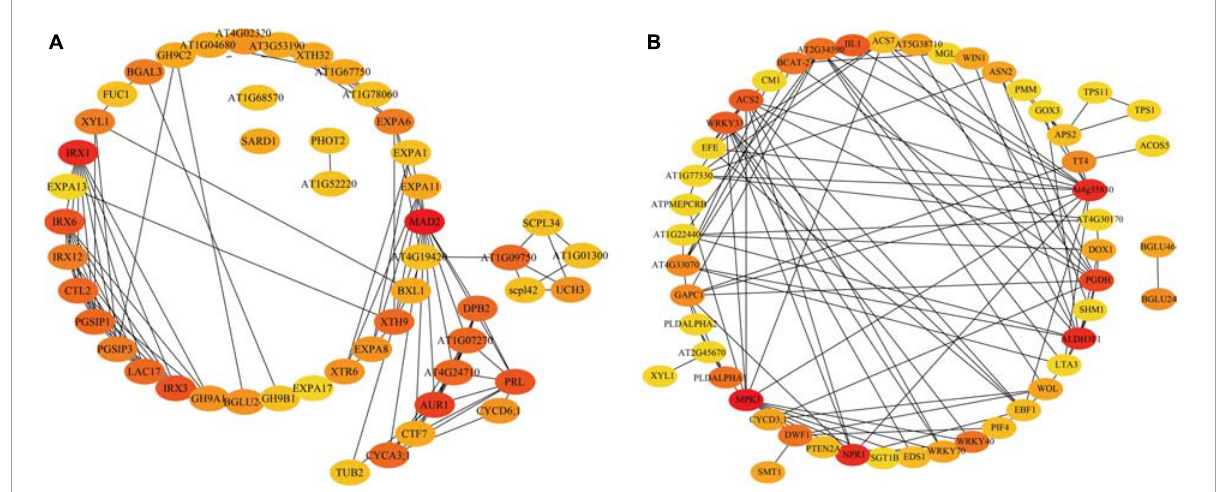
FIGURE6 The DEG protein-protein interaction (PPI) network map. (A) The genes contained in the GO term of interest are plotted for PPI. (B) The genes contained in the KEGG pathway of interest were plotted for PPIs. The shade of the color represents the importance of interaction.